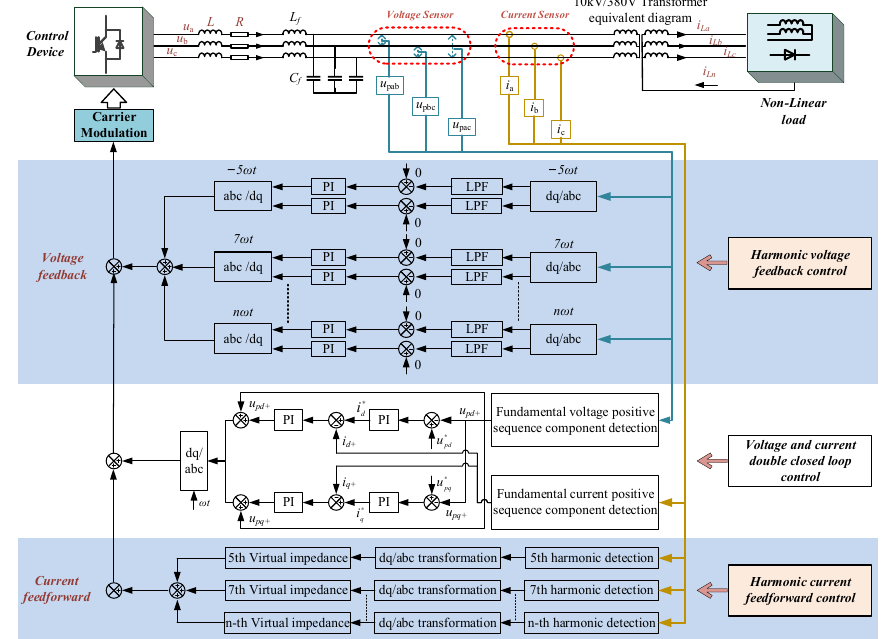
The harmonic voltage feedback control strategy proposed in this paper is shown in Figure 5. In the figure, the harmonic voltage feedback control realizes the suppression of the harmonic voltage at the PCC point.